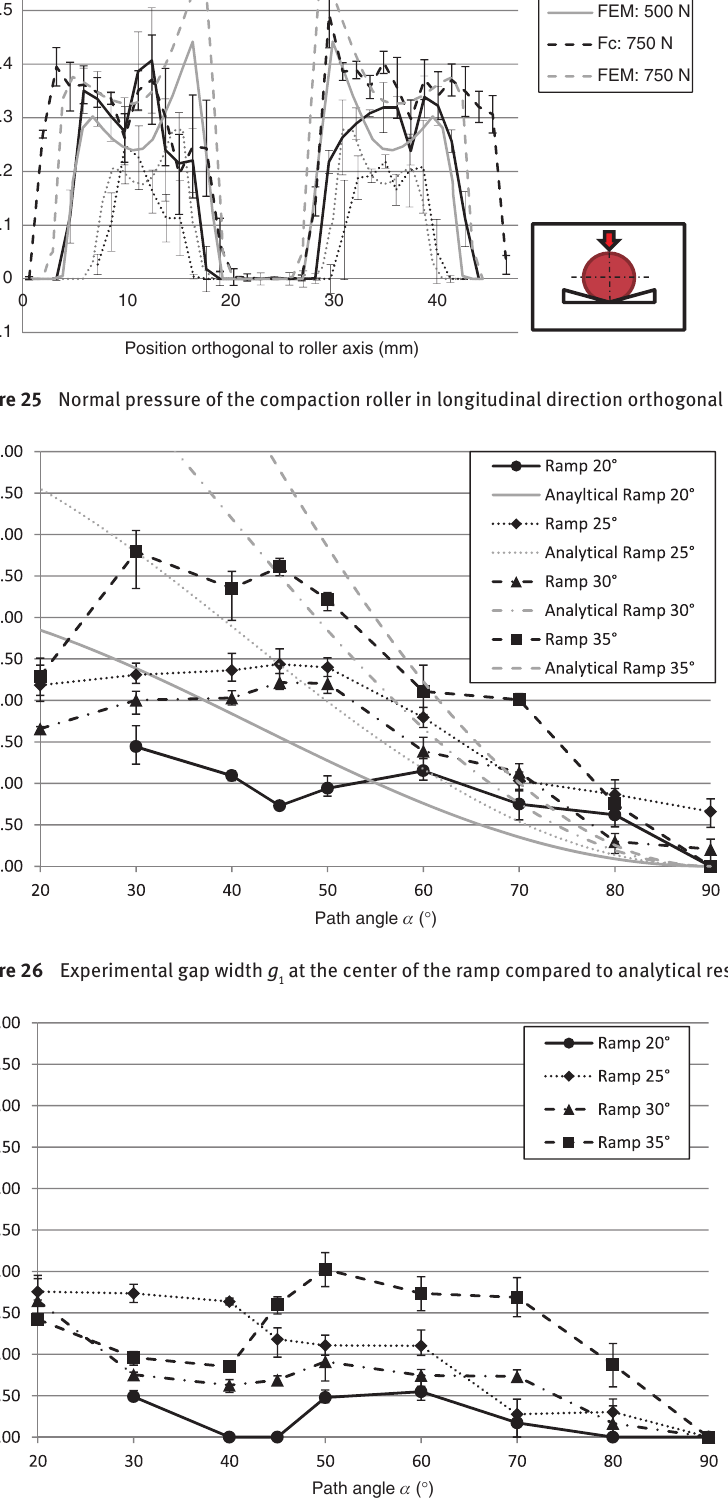
at the top of the 2